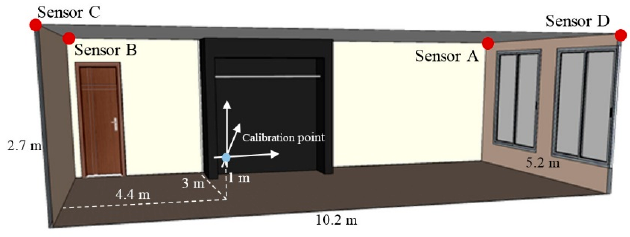
Figure 11. Workspace model where the physical experiment was carried out.